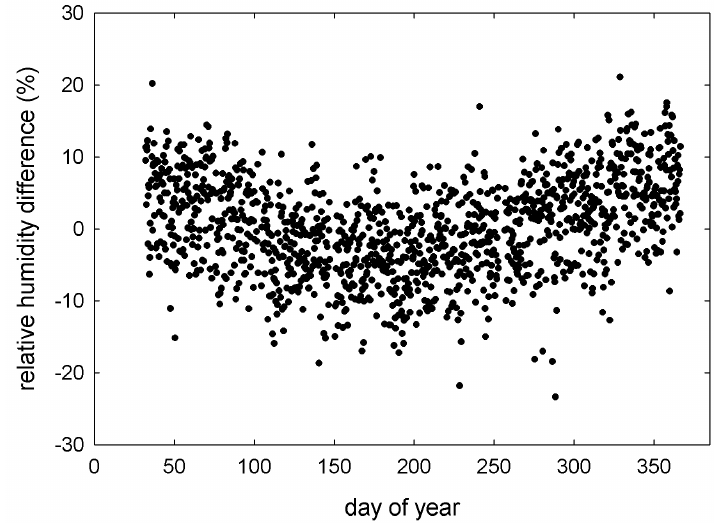
Fig. 10. Hourly differences of relative humidity due to the differences of air temperature values between the M2 grid point and the buoy.